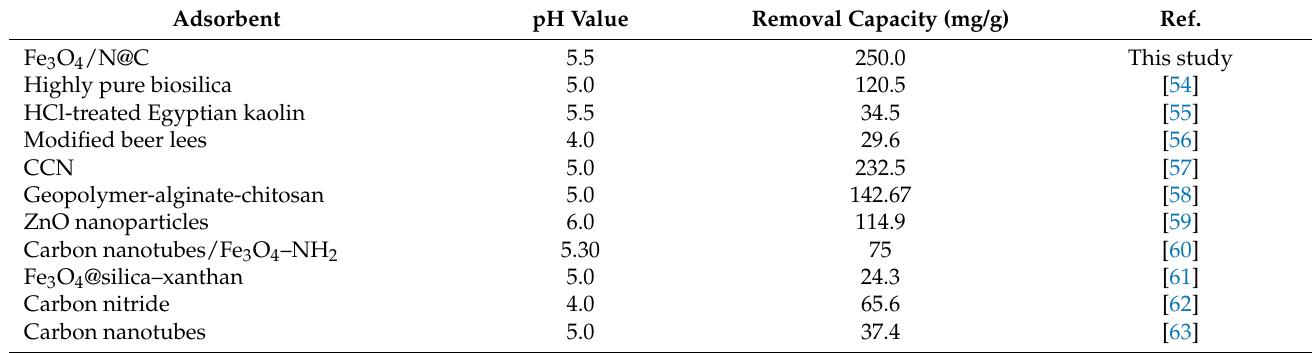
Table 2. Comparison of Fe 3 O 4 /N@C nanocomposite with other adsorbents for the adsorption of Pb 2+